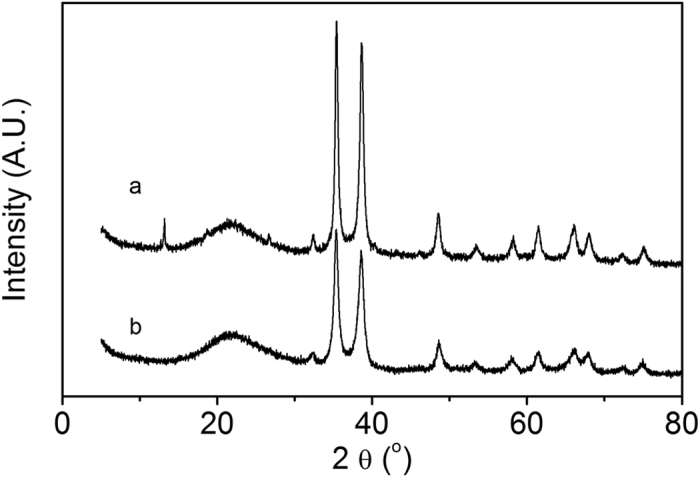
XRD patterns of the two catalysts: (a) CuO/SiO2; (b) CuO/Al2O3-SiO2.